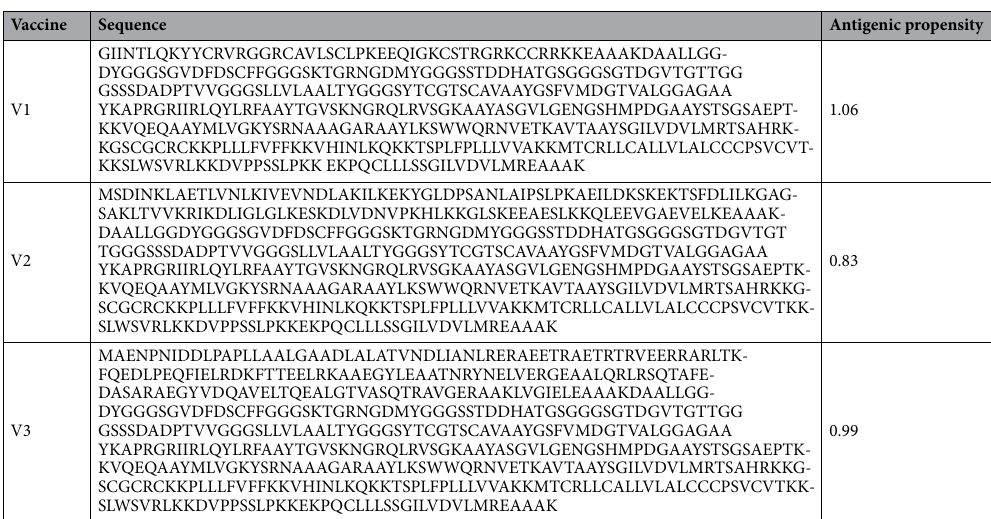
Table 7. The top three vaccine constructs V1, V2, and V3 made using Beta-defensin, L7/L12 Ribosomal protein, and Gaba protein adjuvants along with the top BCL, HTL, and CTL epitope sequences.